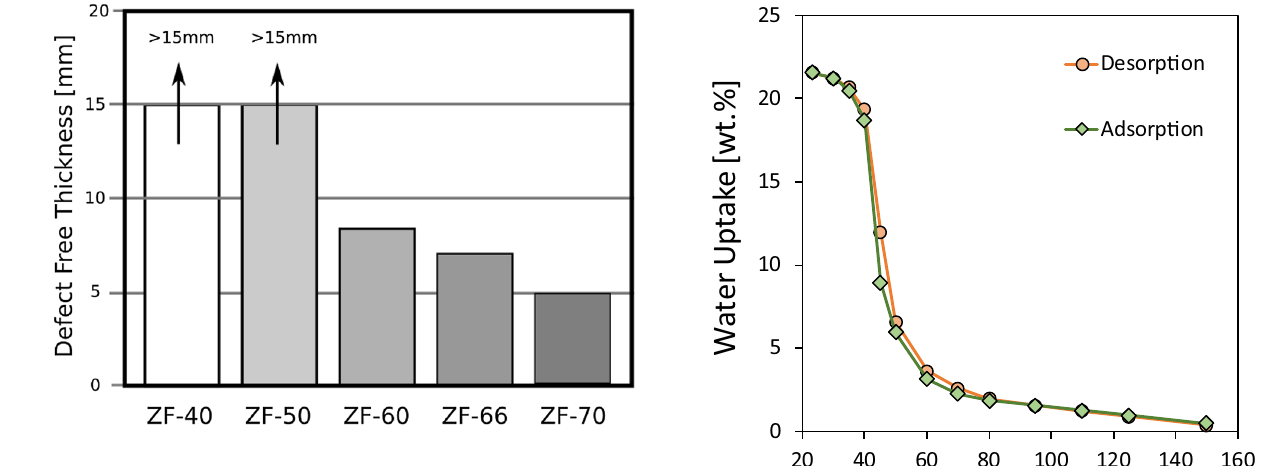
Fig. 5 Defect-free maximum thickness (DFT) parameter for all the composite foams